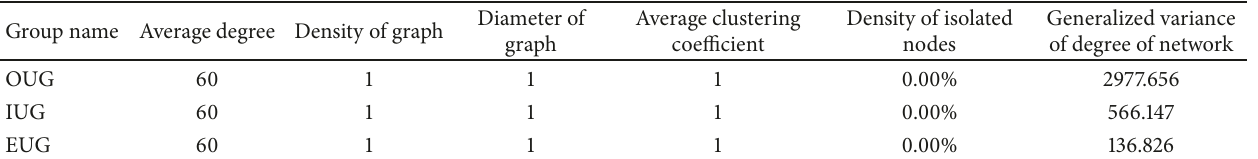
Table 4: The results of null